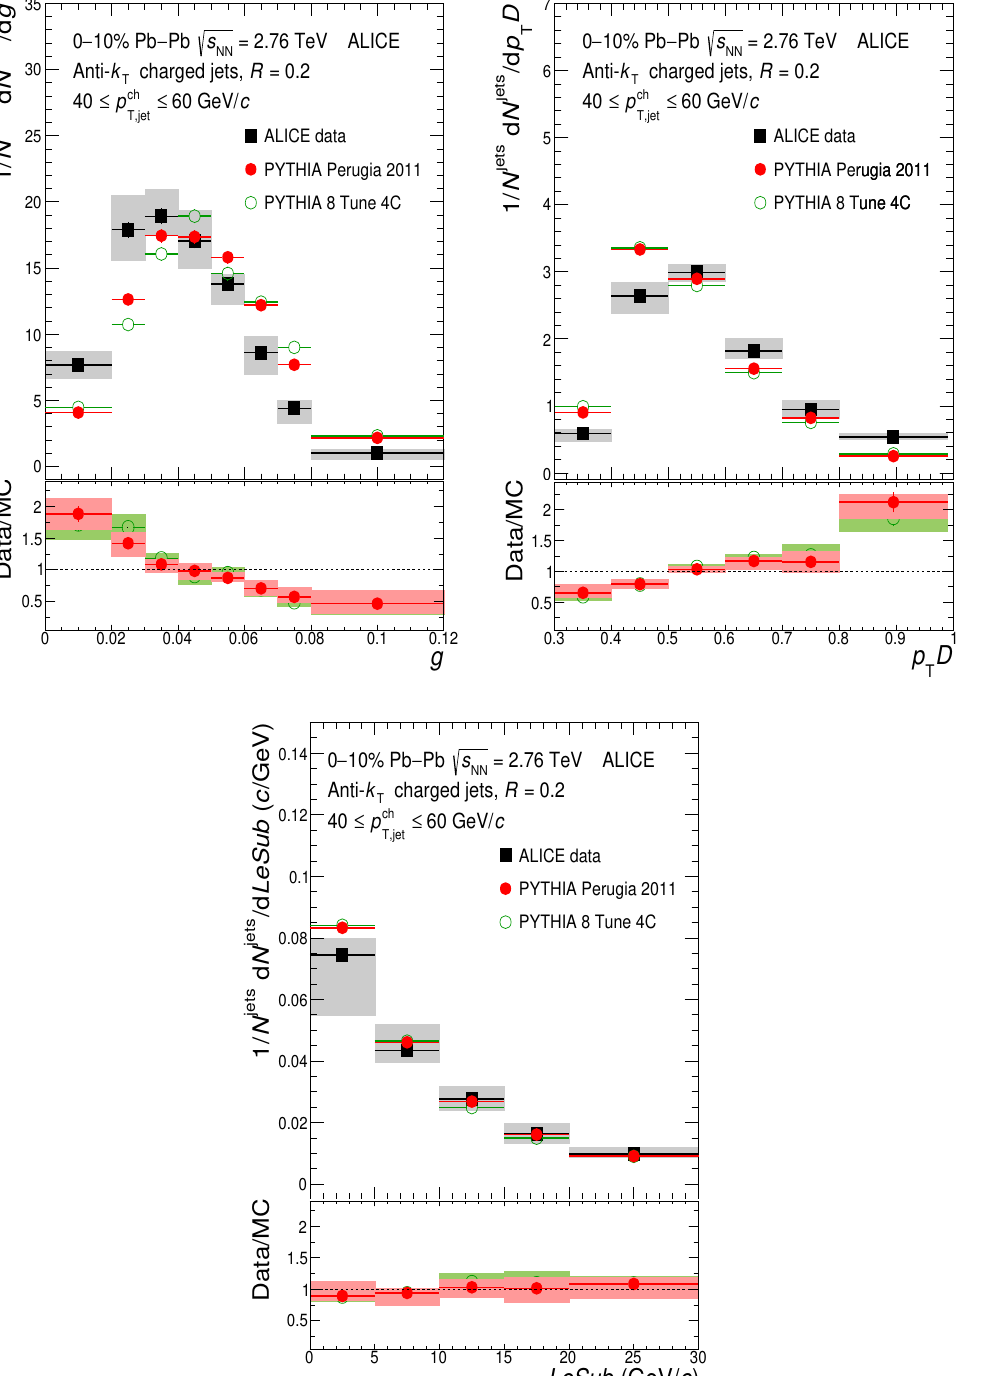
p s NN = of 40{60 GeV =c . The results are compared to T ; jet